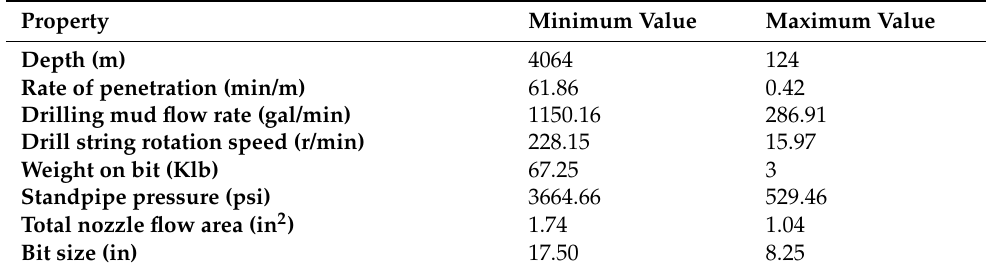
Table 1. The range of data used for the lithology model.